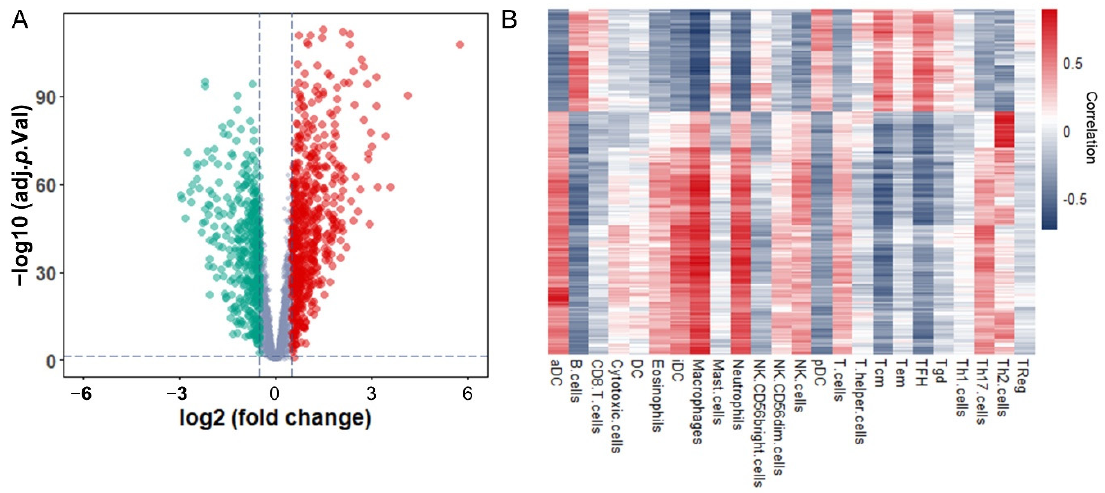
Figure 3. Identification and functional enrichment analysis of immune-associated RBPs in glioma patients: ( A ) Volcano plot representing the differentially expressed immune-associated RBPs between Sub1 ( n = 408) and Sub2 ( n = 283) in glioma. ( B ) Correlation matrix of 216 immune-associated RBPs and 24 types of tumor-infiltrating immune cells.